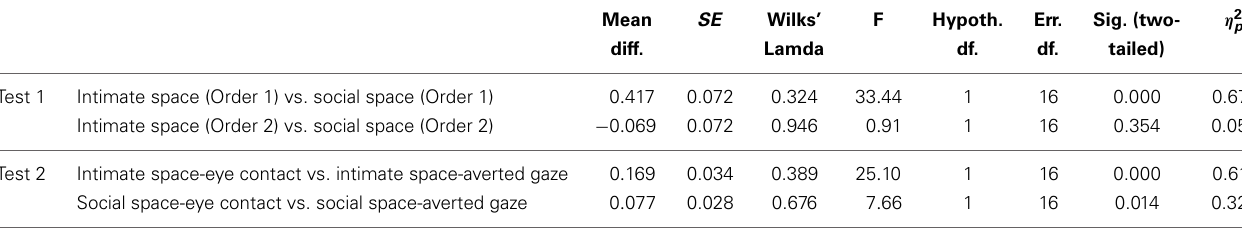
Table 3 | Results of the simple main effect analyses between distance and order as well as distance and gaze. Mean SE Wilks’ F Hypoth. Err. η 2 p diff. Lamda df.